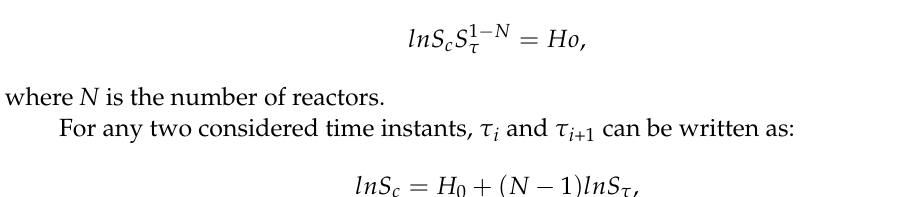
Figure 1. CSTR in-series model for a tubular rotary kiln. Table 1. Indicator concentration in the CSTR in series for various time